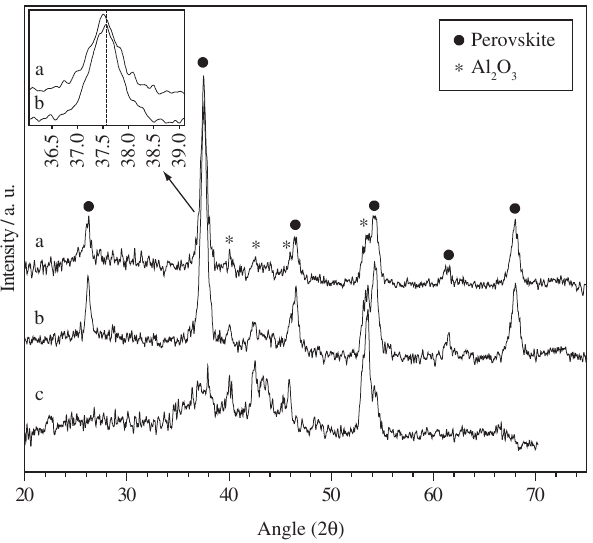
Figure 2. Powder X ray diffraction of the a) LaFe Al